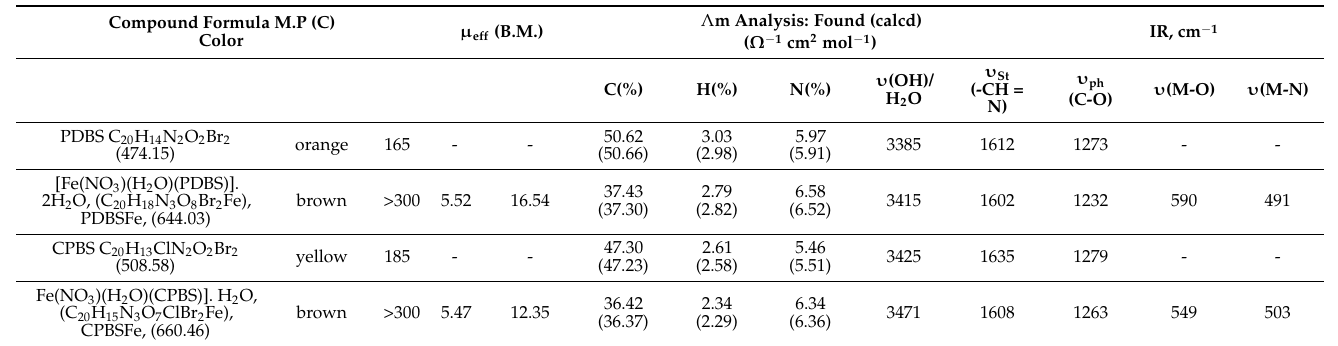
Table 1. Analytical, physical, and IR spectral bands for PDBS and CPBS imine ligands and their iron metal